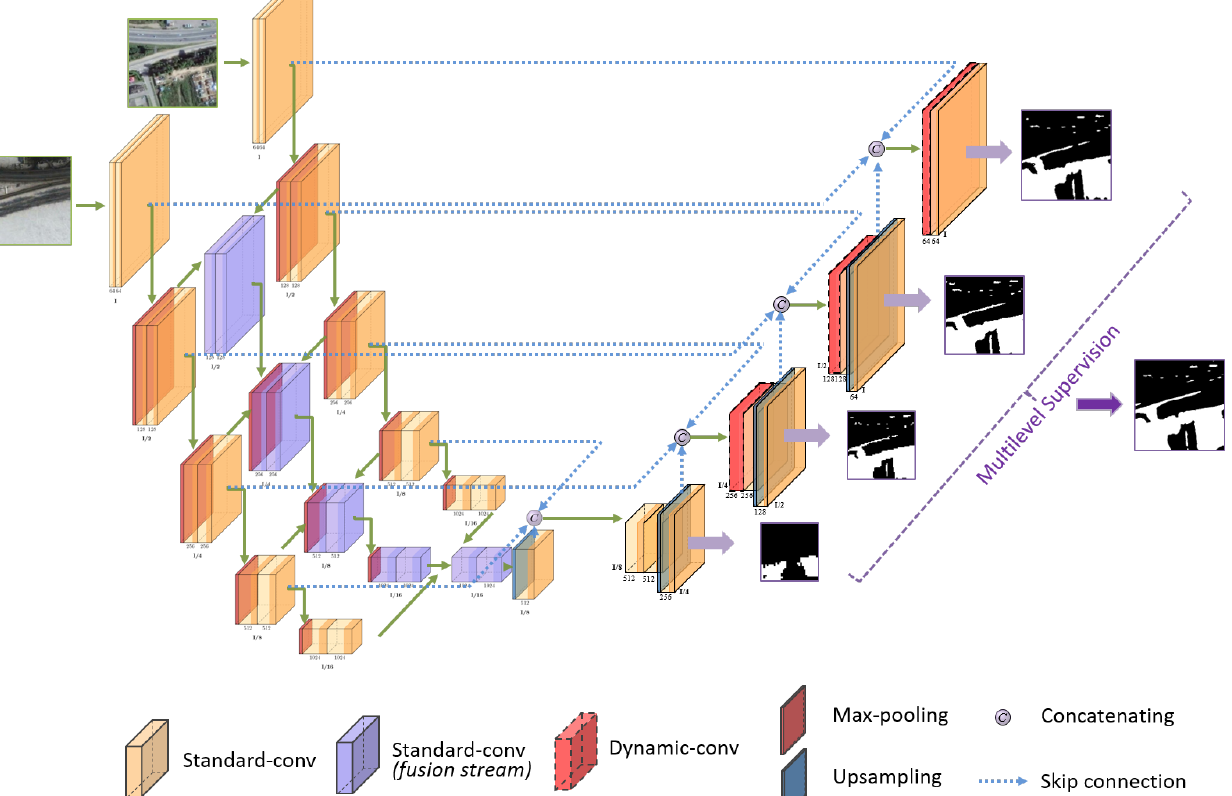
Figure 1. Illustration of hierarchical dynamic fusion network (HDFNet)